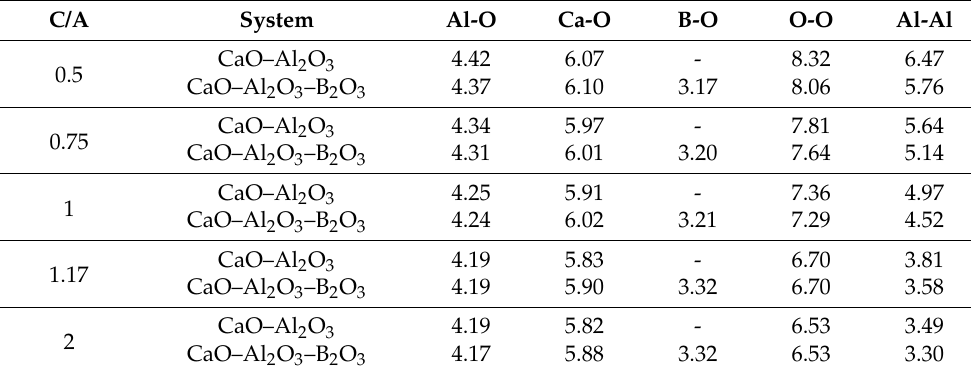
Table 5. Co-ordination numbers of different particle pairs with different CaO/Al 2 O 3 mole ratio systems in this